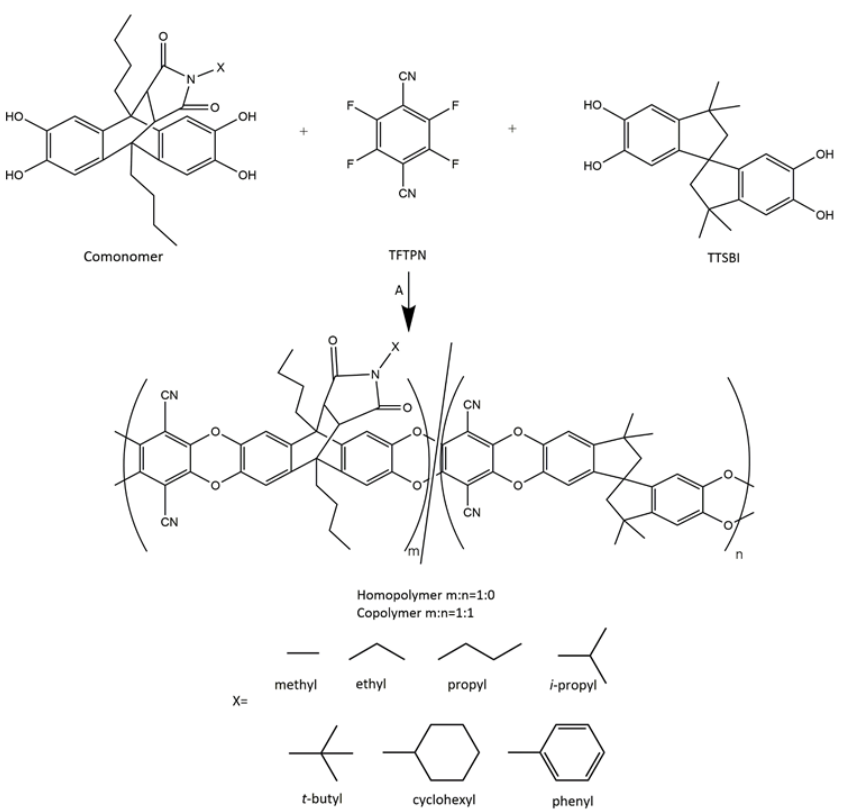
Figure 4. Synthesis of homopolymer and copolymer, A: reagents and conditions DMAc, DEB (for copolymer), K 2 CO 3 , 150 °C, 30–60 min.